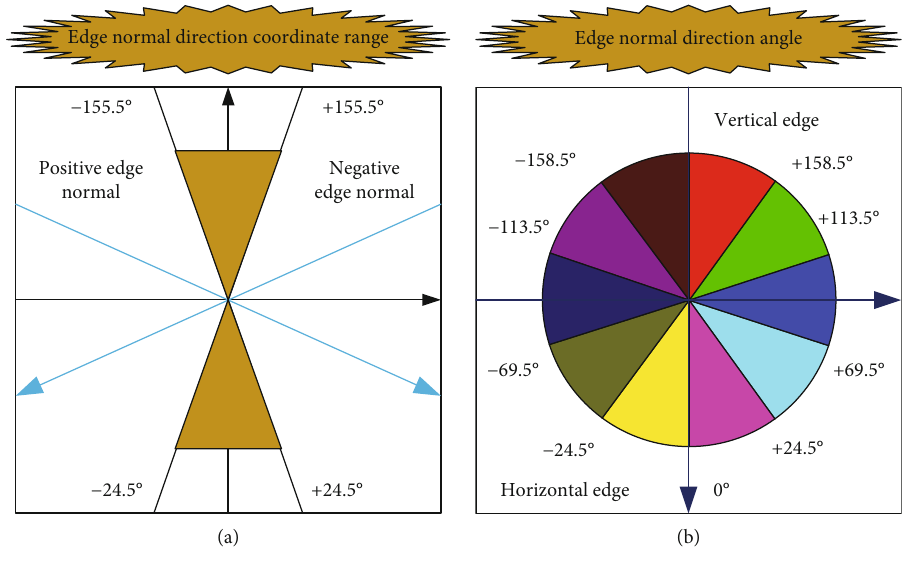
Figure 2: The angle of direction of edge